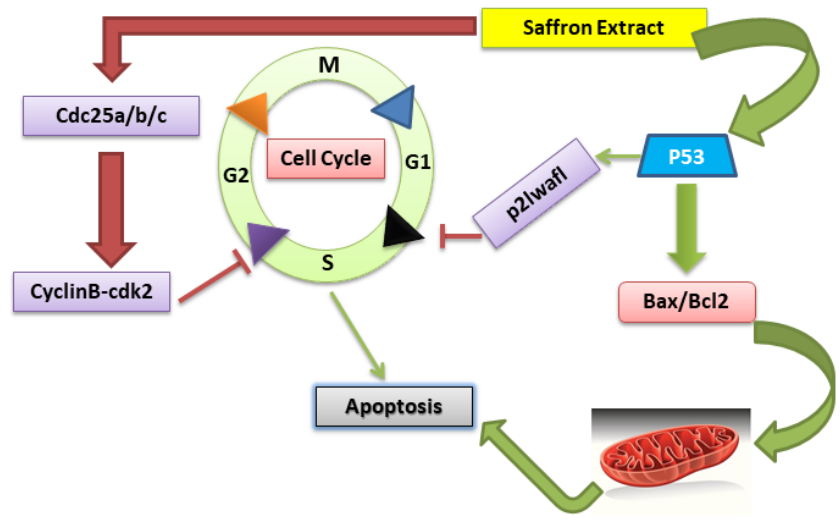
Figure 1. Crocus sativus extract a ff ects the cell cycle by blocking the G2 and S phase via p53 and CyclinB-cdk2 proteins. Cancer cells with p53 loss of function have a dysfunctional G1 / S checkpoint whereas the G2 / M checkpoint may still be functional. When cells are exposed to sa ff ron extract, it causes G1 / S arrest via activation of the p53 pathway while G2 / M arrest by inhibiting CyclinB − cdk2 (cyclin-dependent kinases), provoking apoptosis of cancer cells. p53 also leads to increasing the Bax and decreasing Bcl2 expression which leads to morphological changes that contributes to